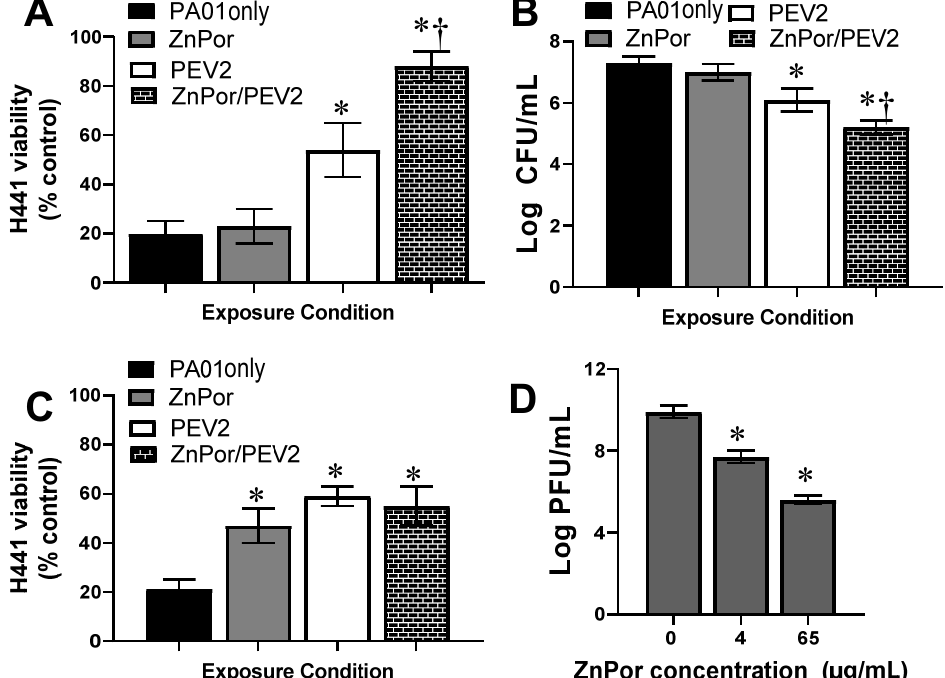
Figure 4. Effect of ZnPor, PEV2, and both on H441 lung cell viability and reduction of PsA PAO1 cell populations in vitro. Following establishment of PsA–H441 infections, cells were supplemented with (1) ZnPor alone at 4 or 65 µg/mL, (2) PEV2 alone (MOI 1:1), or (3) both ZnPor and PEV2. ( A ) H441 cell viability was measured after 24 h for all experimental conditions with 4 µg/mL ZnPor. ( B ) PsA bacterial viability was assessed after 24 h exposure to ZnPor (4 µg/mL), PEV2 (1:1 MOI), or both concurrently by measuring CFU/mL. ( C ) H441 cell viability was measured after 24 h for all experi- mental conditions with a ZnPor dosage of 65 µg/mL. ( D ) Following the establishment of an H441- PsA infection, ZnPor was added at either 4 or 65 µg/mL and PEV2 at 84 PFU/mL, and incubated for 24 h. PFU/mL levels decreased signi fi cantly at both ZnPor concentrations, indicating that ZnPor was reducing PEV2 activity. * Comparison to untreated control; † comparison of PEV2 and PEV2/ZnPor treatment ( p < 0.05, n = 3). CFU/mL, colony-forming units/mL; MOI, multiplicity of infection; PFU/mL, plaque-forming units/mL.